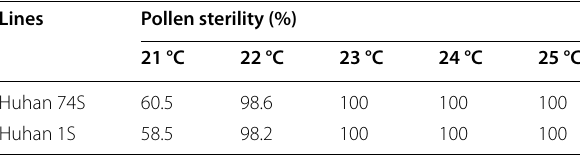
Table 5 Fertility-sterility alteration behavior of Huhan74S and Huhan 1S under five different temperature